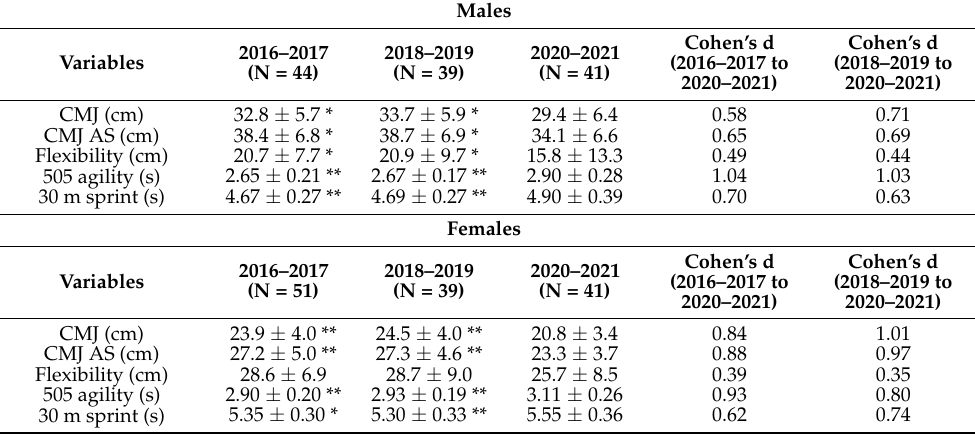
Table 2. Lower-body fitness test results at different school years by sex (mean ±